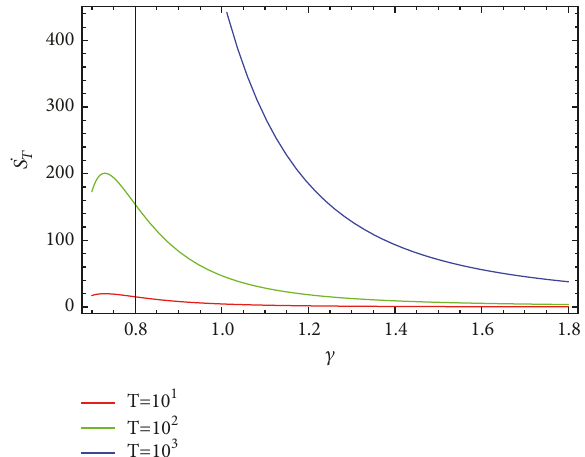
̇𝑆 𝛾 for power law 𝑇 versus